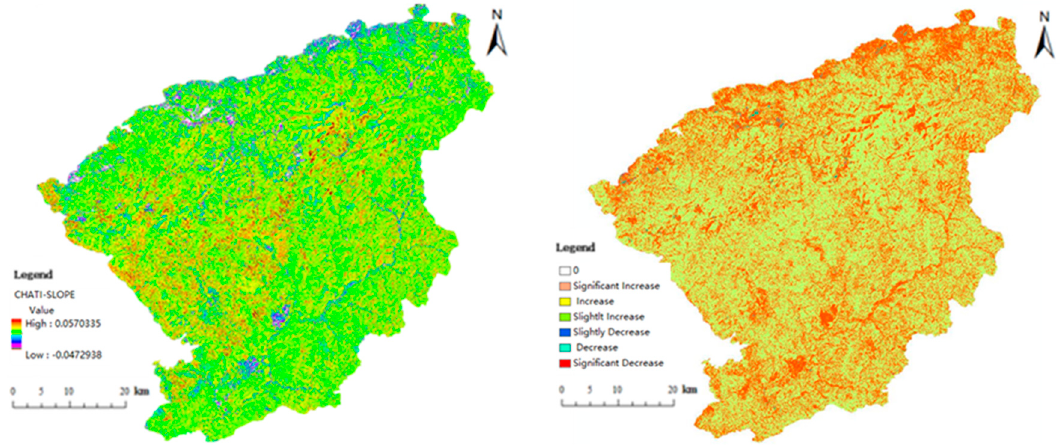
Figure17. Figure 17. The spatial distribution of the variation trend of CHATI value from 1987–2018 in Mount Wutai.